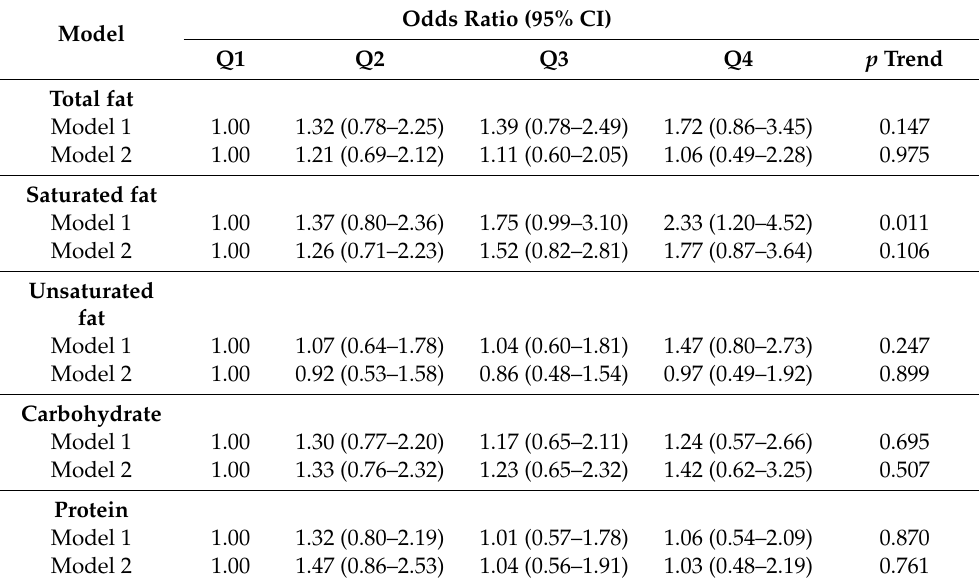
Figure 2. Prevalence of excessive daytime sleepiness by quartiles of energy intake from macronutrients (Q1, lowest energy intake; Q2, highest energy intake). Table 2. Odds ratios (95% confidence intervals) for excessive daytime sleepiness associated with quartile of energy from macronutrients (per day) in the North West Adelaide Health